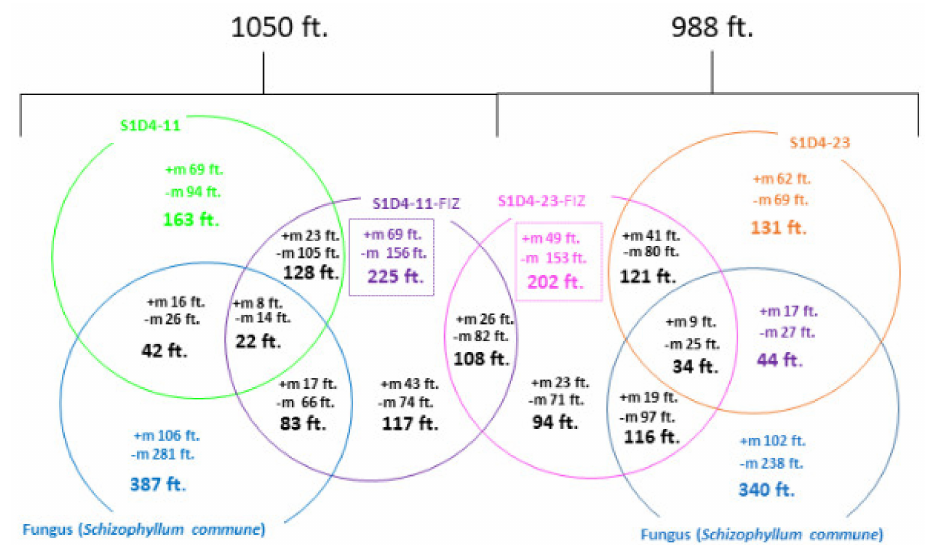
Figure 4. Distribution of common and specific features between SFIZs and controls. LC-MS metabolite profiles were recorded and analyzed with GNPS. The Venn diagram compares specific and common features between each SFIZ and its controls as well as SFIZ features between the two experiments. The number of SFIZ specific features for each experiment is indicated in the dashed square. +m: positive mode; − m: negative mode; ft.: